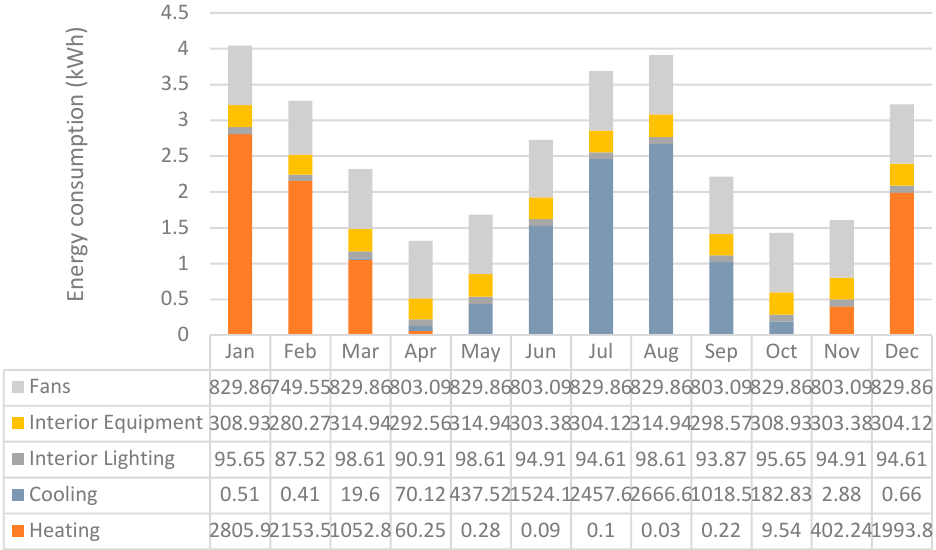
Figure 6. Energy consumption of various equipment of CASE-A.